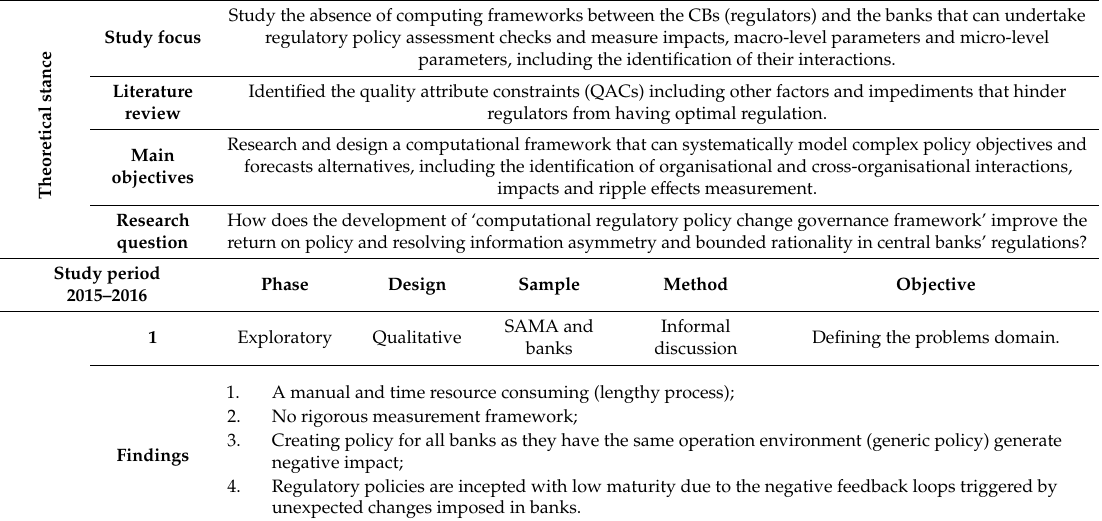
Table 1. Summary of the study and the research